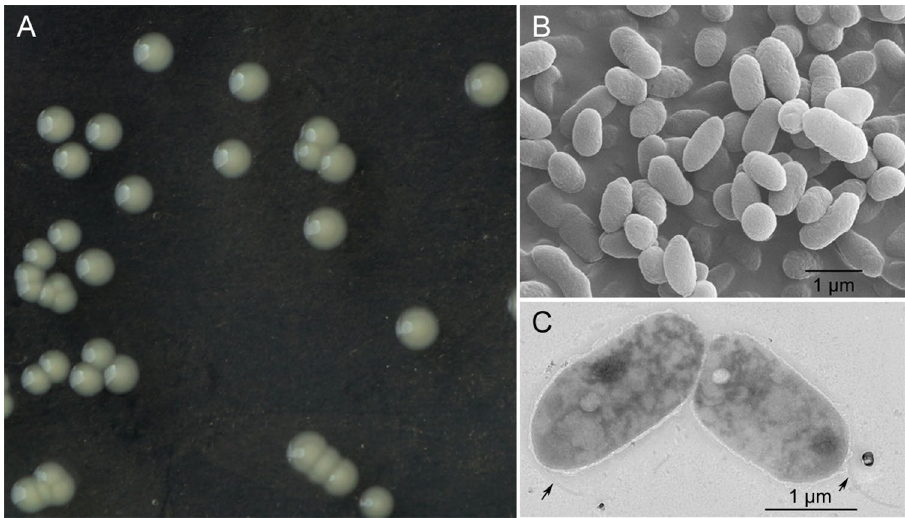
Figure 4. Colonies of Pseudomonas eucalypticola NP-1 T grown on LA medium at 25 °C for 48 h (A). The bacterial morphology was obtained by scanning electron microscopy (B), and the transmission electron microscopy showed the presence of a single polar flagellum (C, black arrows). Bar = 1 μm.